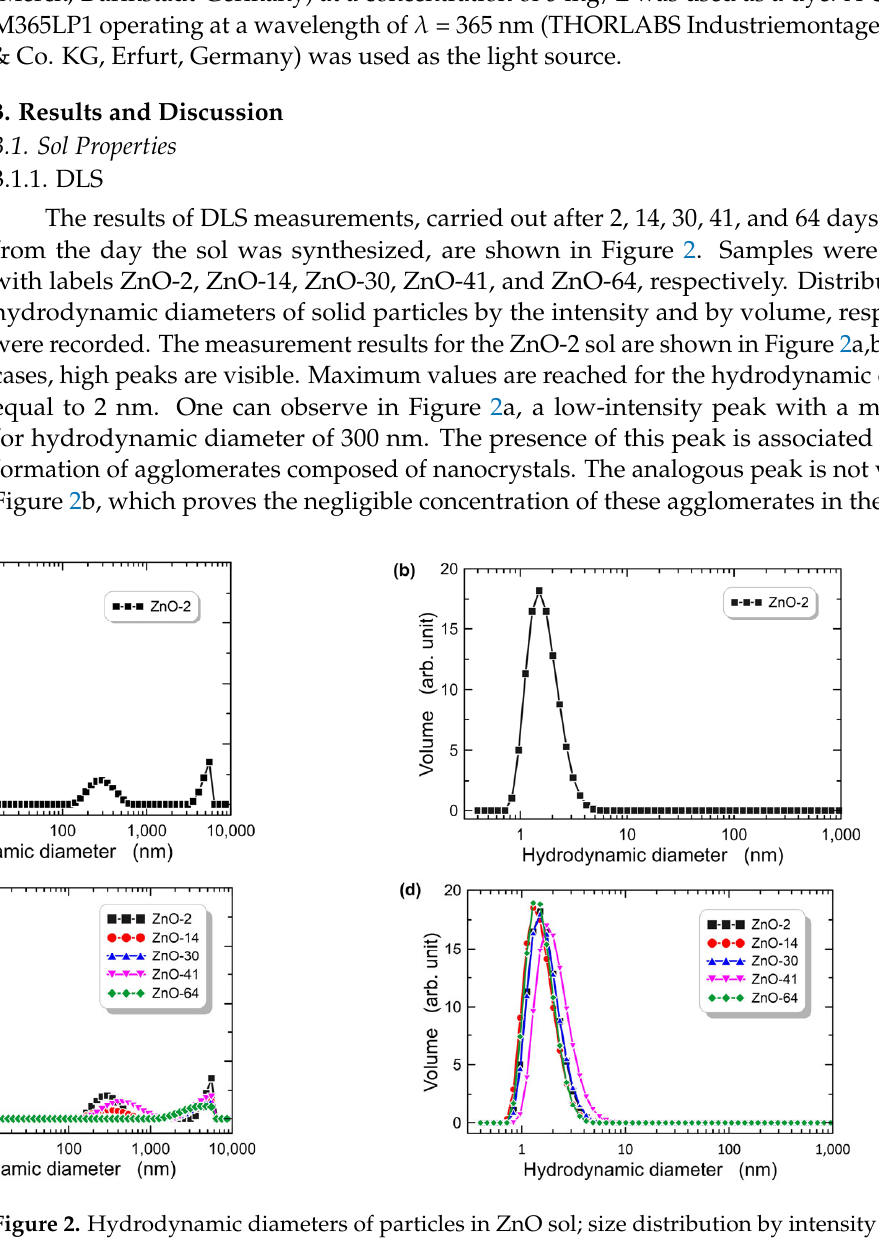
Figure 2. Hydrodynamic diameters of particles in ZnO sol; size distribution by intensity ( a , c ), and size distribution by volume ( b , d ).